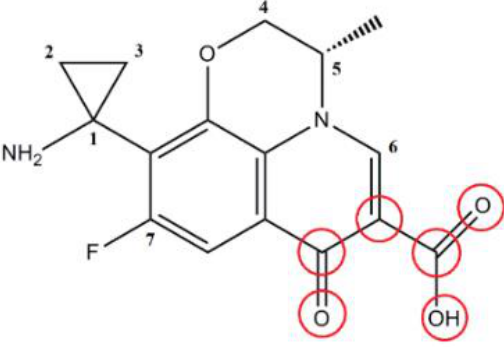
Figure 4. Selecting the target compound to align with the common framework.